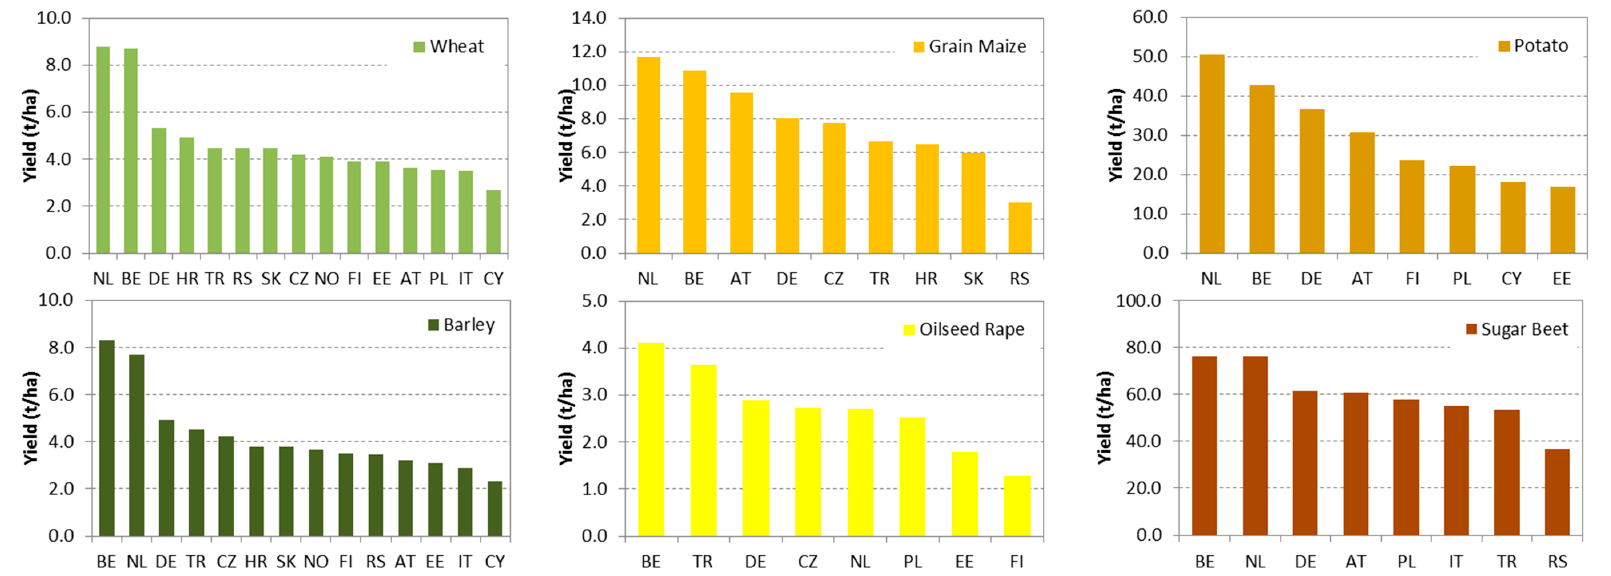
Figure 3. Yields (Mg ∙ ha − 1 ) for major arable crops across the European regions for the year 2012 based on regional statistics. A two letter code refers to the country that the region belongs to.